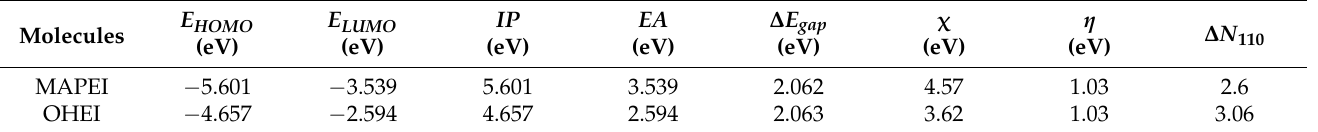
Table 5. Calculated quantum chemical parameters of MAPEI and OHEI using DFT/GGA/DNP.